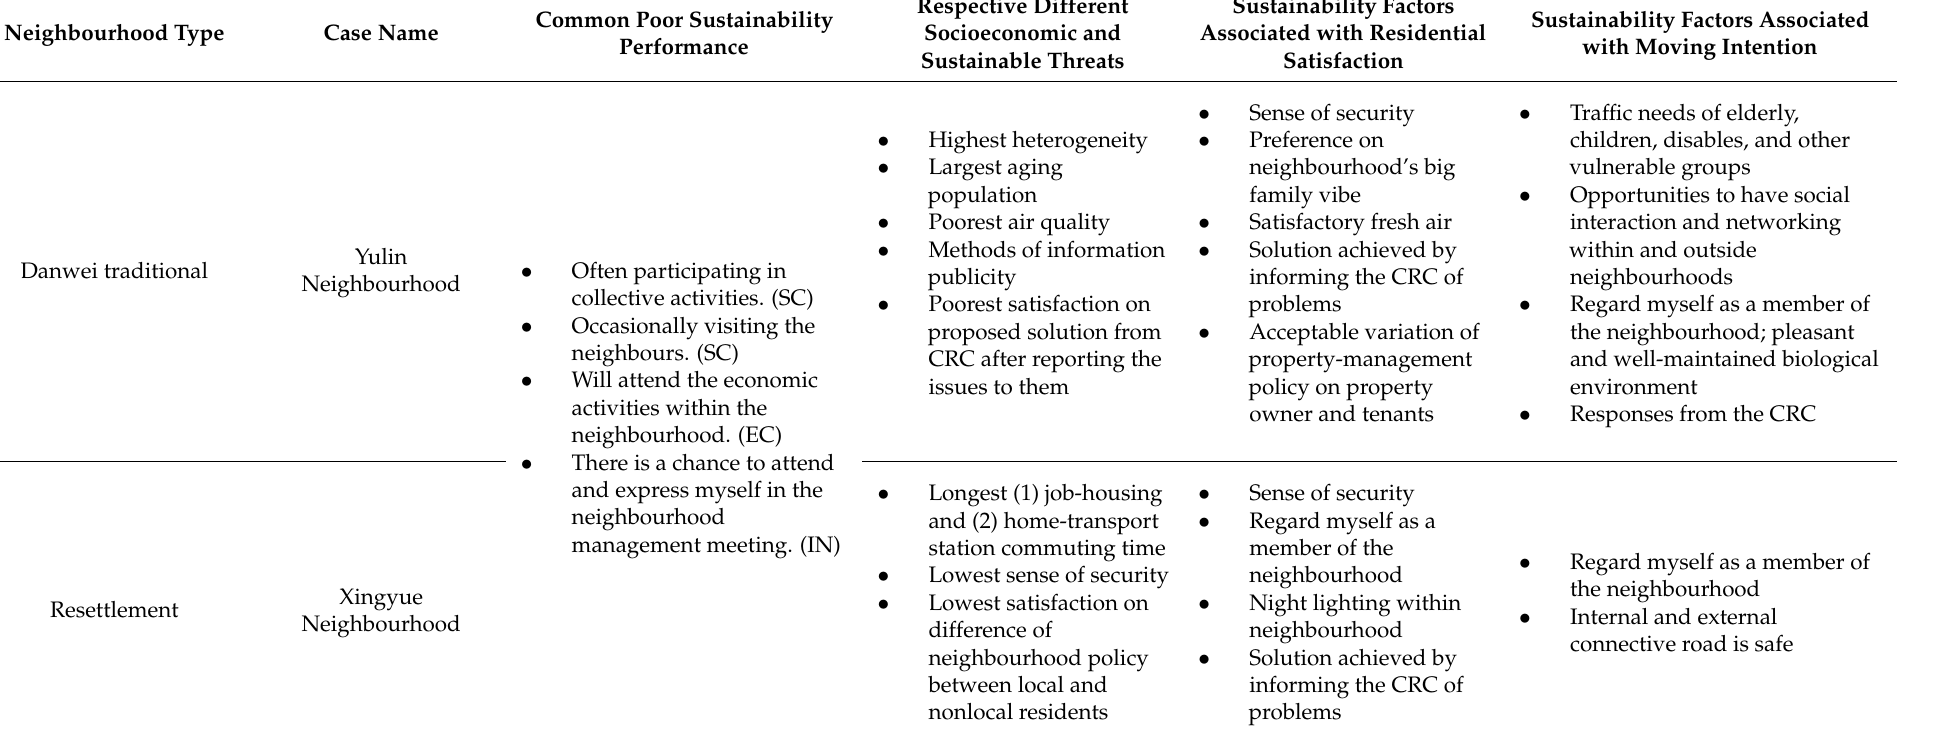
Table A2. Key identified factors of three neighbourhoods through empirical study in